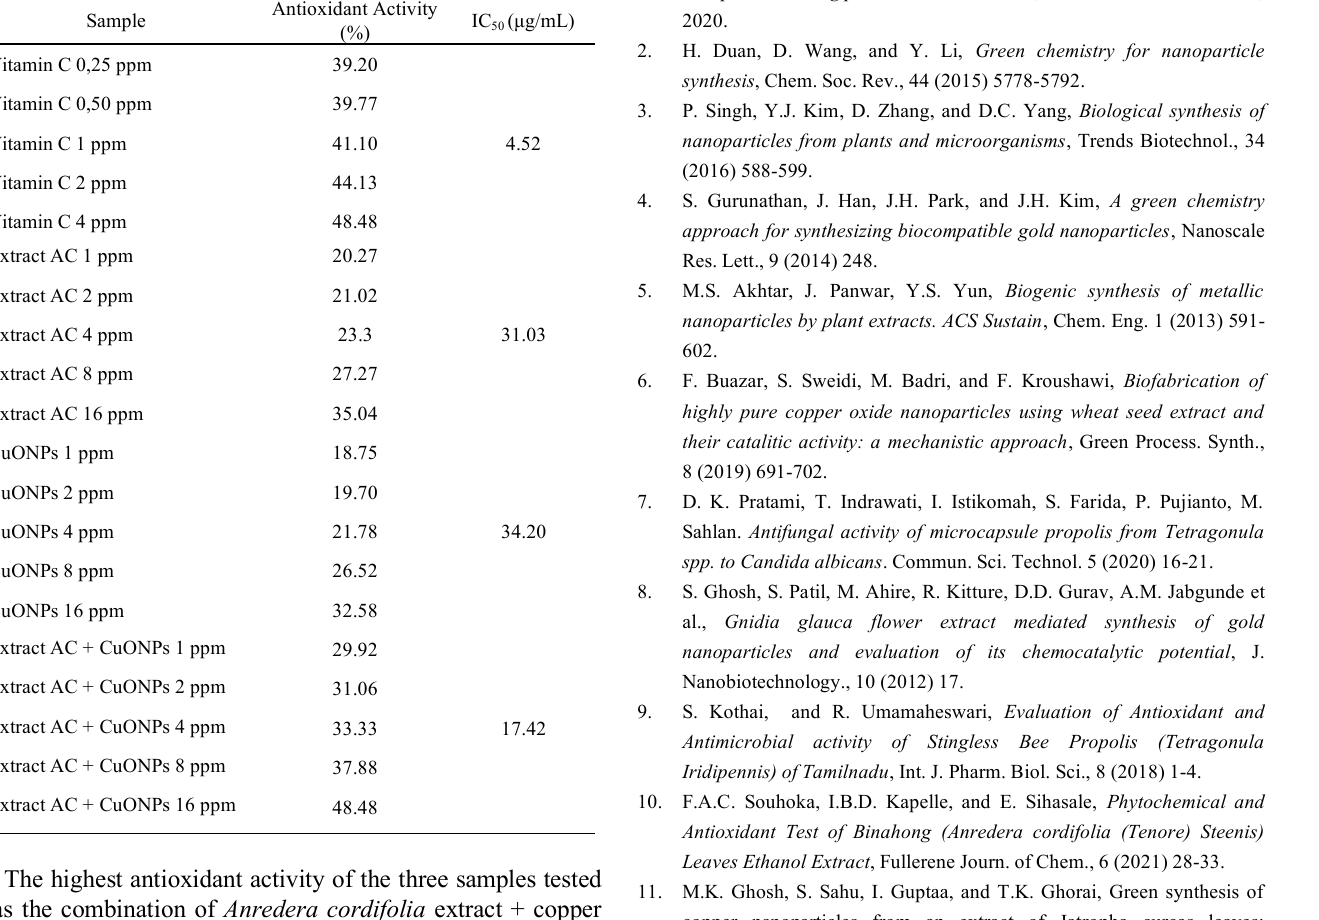
Fig. 11. DPPH Assay of the synthesized (a) Extract AC, (b) CuONPs, and (c) combination extract AC + CuONPs Table 6. Antioxidant activity of vitamin C and the sample